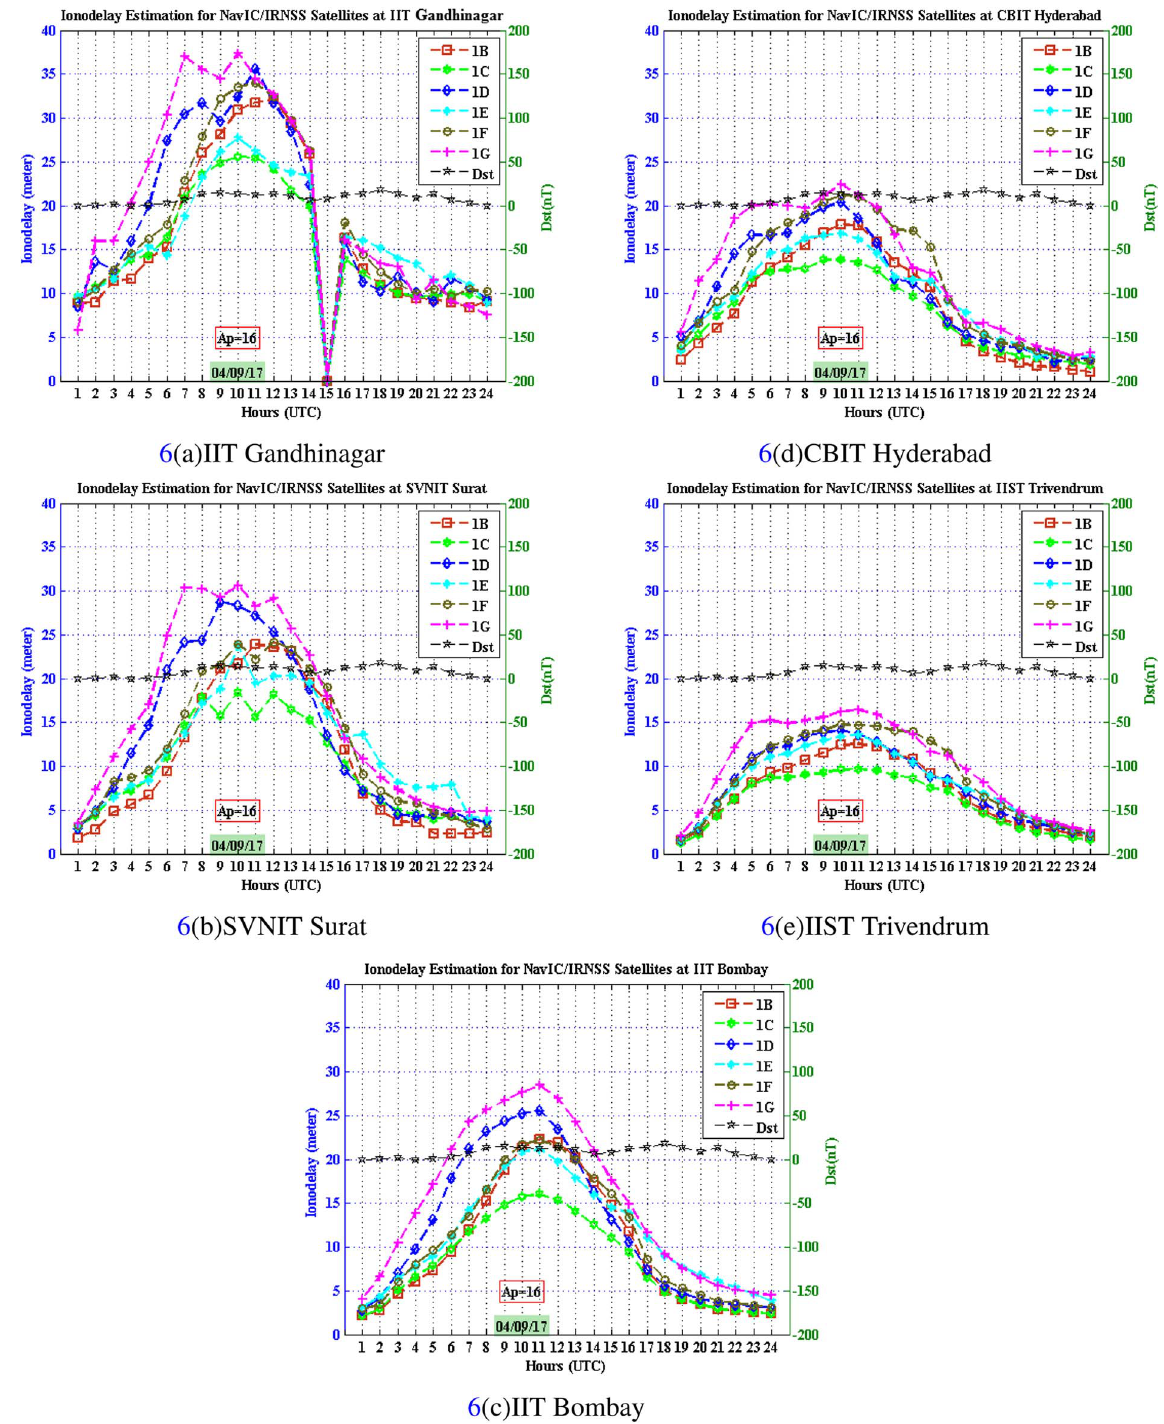
Fig. 6. Dual frequency ionodelay comparison of NavIC/IRNSS 1B – 1G satellites for observed geographical